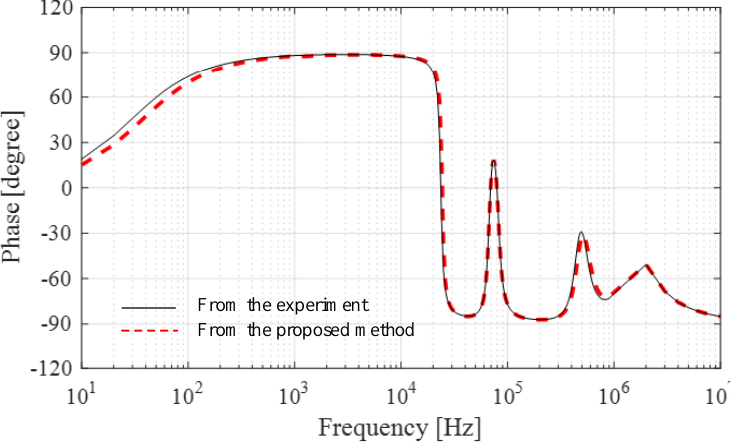
Figure 17. Phase of input impedances of the transformer winding from the measurement and by the proposed method.